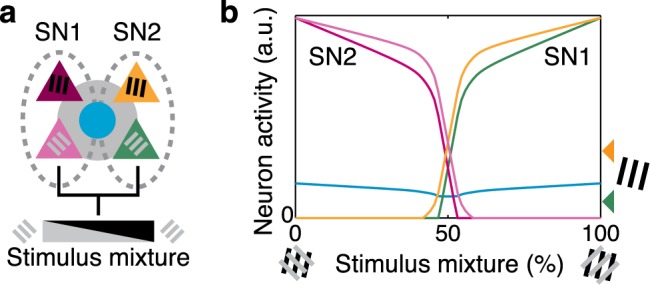
Non-random connectivity supports autoassociative behaviour.In a simple model with two subnetworks (a), presenting a linear graduated mixture between the ideal stimuli for the two subnetworks (b) results in competition and switching between network representations. When the stimulus is ideal for one subnetwork (mixture = 0% or 100%), then strong amplification of the network response occurs (compare with response of SN1 to a single grating component; arrowheads at right of b). When an approximately even mixture is presented (close to 50%), the network switches rapidly from one representation to the other. Proportion of specific excitatory synapses s = 25%. Dashed ovals: neurons grouped by specific excitatory connectivity. Other conventions as in Fig 1. a.u.: arbitrary units.